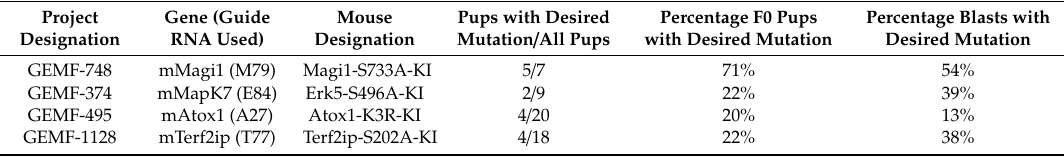
Table 2. Comparison of the percentages of desired mutation integration between blastocyst and mouse. Guide / donor pairs giving the better or best rate of desired mutation in blastocysts were usually used to make mice. For each gene being altered, the percentage of pups born with the desired mutation was compared to the percentage of blastocysts with the same mutation. A roughly similar pattern of insertional frequency was found between mice and blastocysts for the corresponding altered